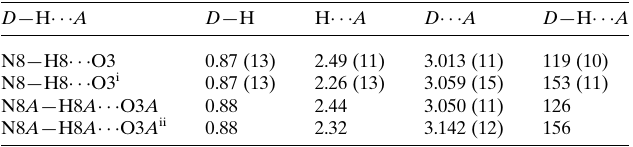
Table 1 Hydrogen-bond geometry (A˚ , (cid:2) ).